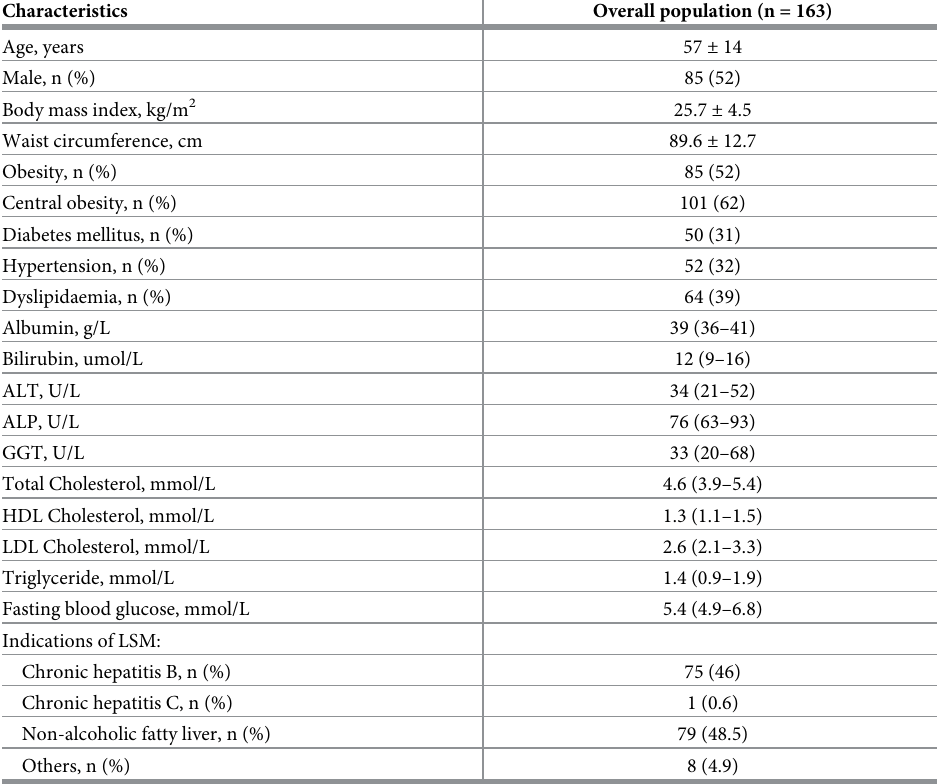
Table 1. Baseline characteristics of study